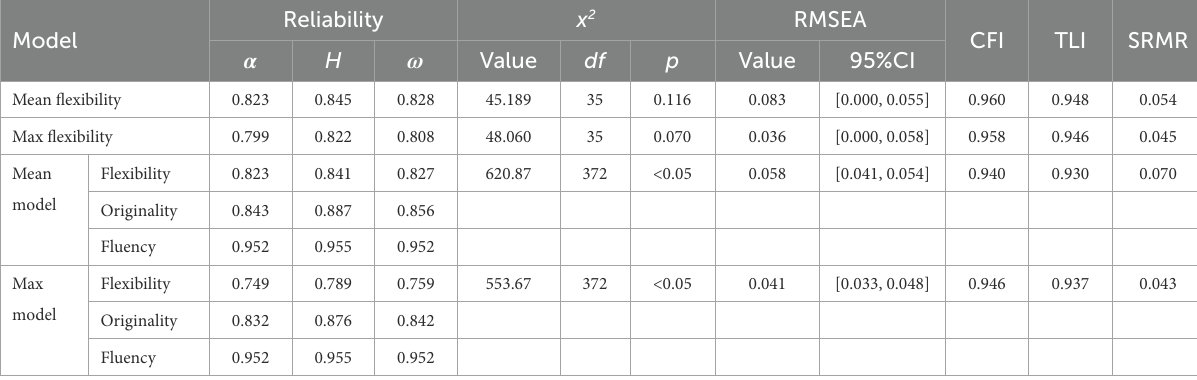
TABLE 4 Model fit statistics.